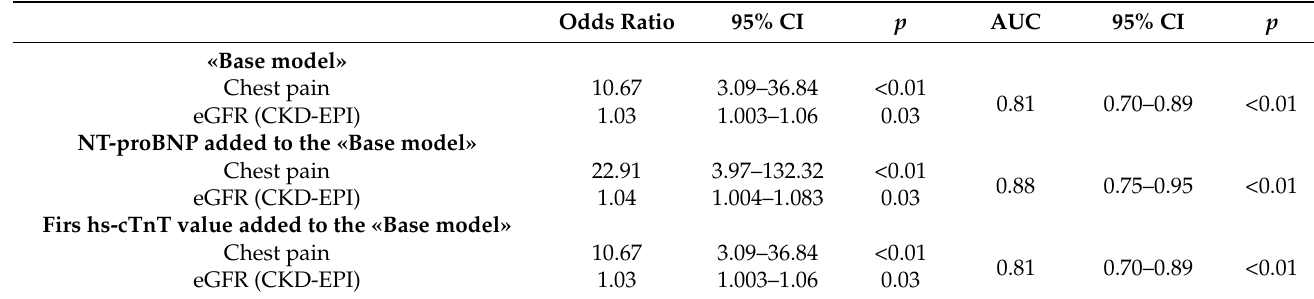
Table 4. Multivariable models—ACS versus Non-ACS cardiovascular